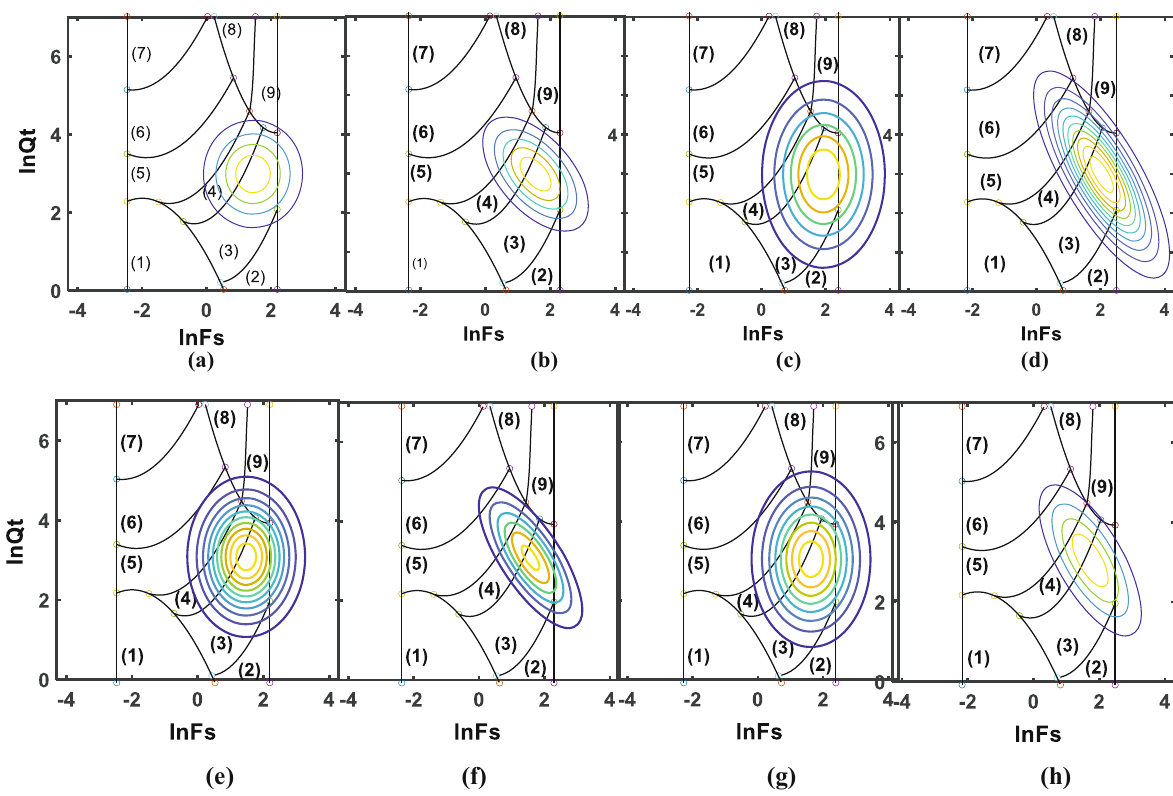
Figure 5: ( a ) Data of CPT1on the Robertson chart simulated by DC matrix, ( b ) full matrix, ( c ) data of CPT2 on Robertson chart by DC, ( d ) full matrix, ( e ) data of CPT3 on Robertson chart by diagonal matrix, ( f ) full matrix, ( g ) data of CPT4 on Robertson chart by diagonal matrix, and ( h ) full